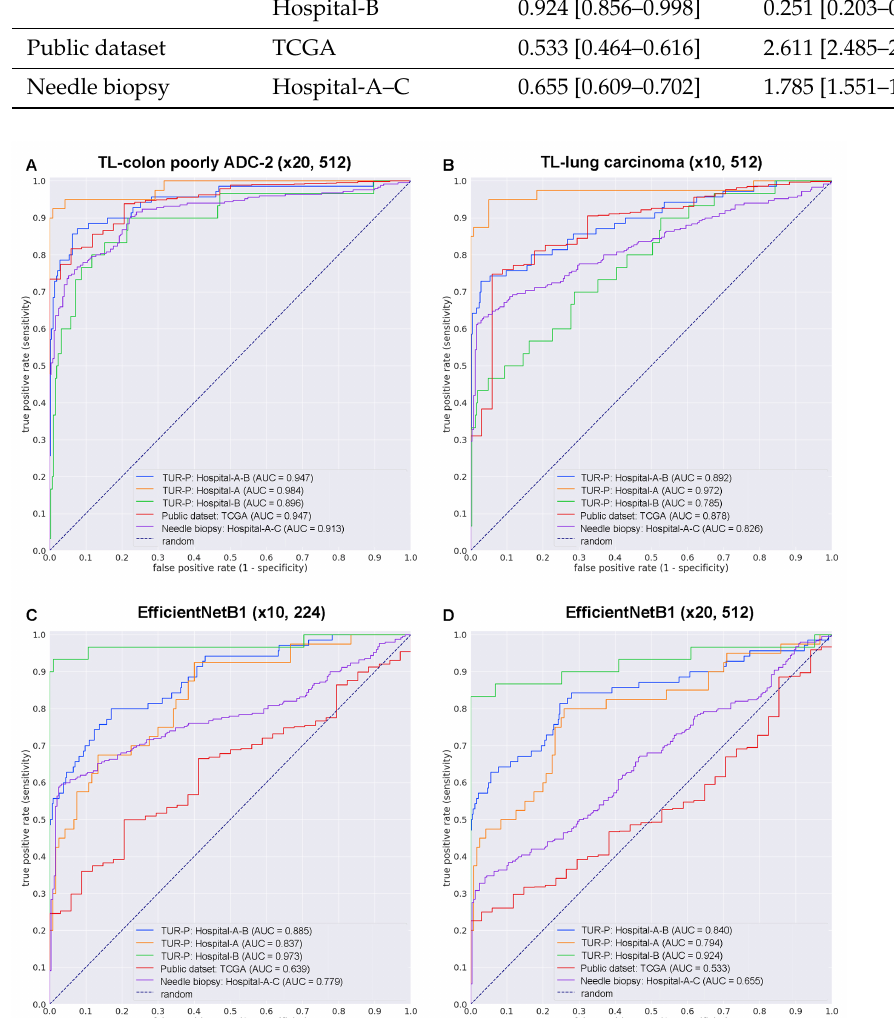
Figure 2. ROC curves with AUCs from four different trained deep learning models ( A – D ) on the test sets: ( A ) transfer learning (TL) model from an existing colon poorly differentiated adenocarcinoma (ADC) classification model with a tile size of 224 px and magnification at × 20; ( B ) TL model from an existing lung carcinoma classification model with a tile size of 512 px and magnification at × 10; ( C ) EfficientNetB1 model with a tile size of 224 px and magnification at × 10; and ( D ) EfficientNetB1 model with a tile size of 512 px and magnification at ×